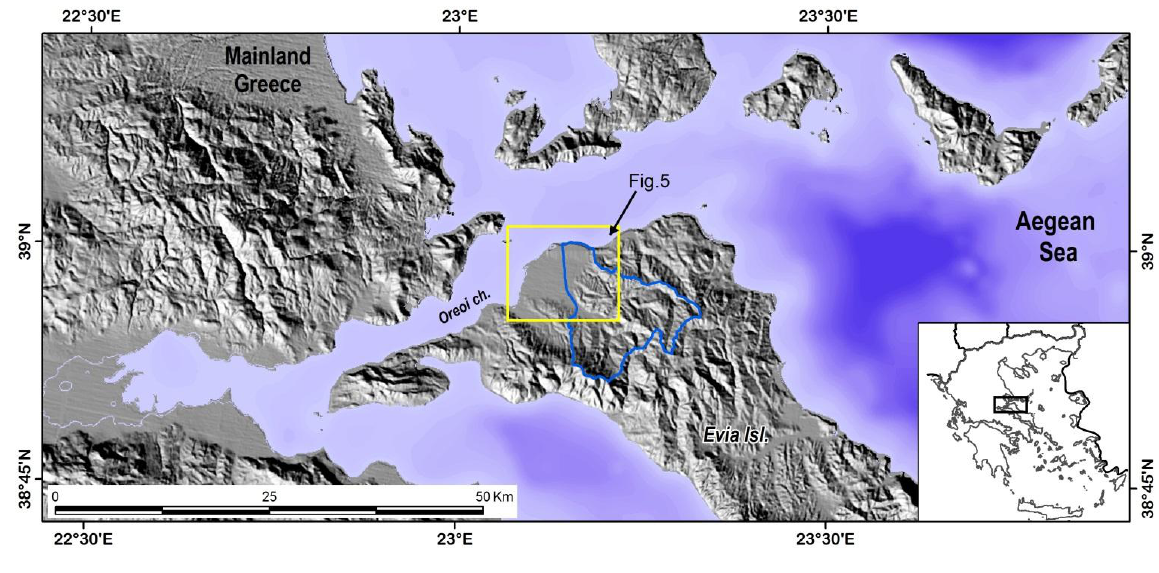
Figure 1. Location map of the study area in Central Greece at which the described methodology was applied. The blue line outlines the Xiropotamos River contemporary catchment